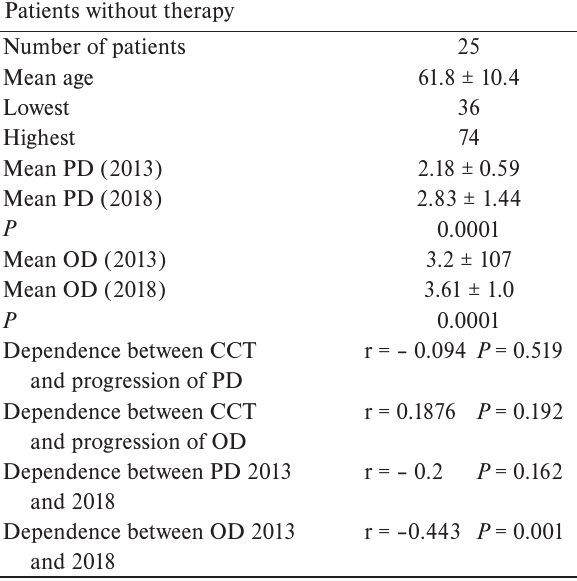
Table 1. The observed values in patients treated with prostaglandins. Patients treated with